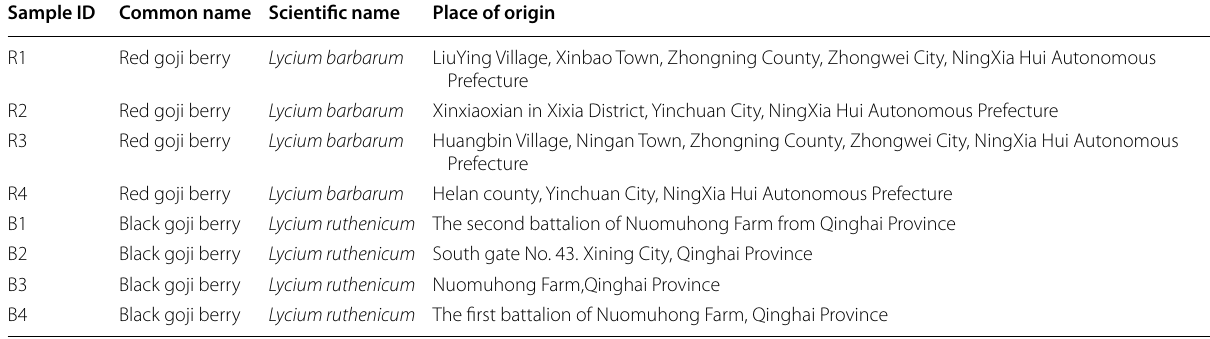
Table 1 Sample information of goji berry collected Sample ID Common name Scientific